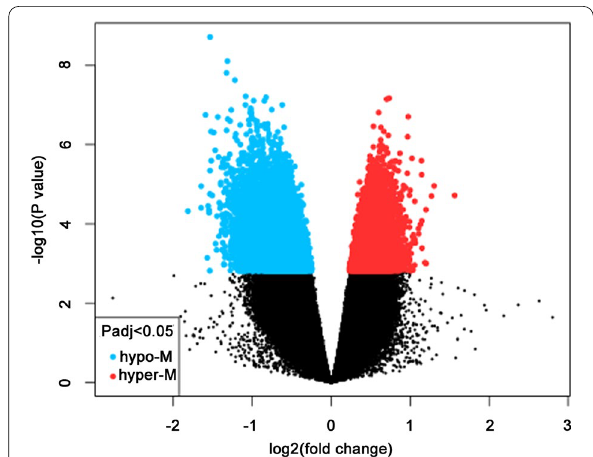
Fig. 1 Volcano plot of methylation difference in periodontitis. A total of 621 hypo-methylated and 47 hyper-methylated genes in periodontitis with p < 0.05 and [logFC] > 1. Hyper-methylated genes were represented by red point in the right side, while hypo-methylated genes were represented by blue point in the left side